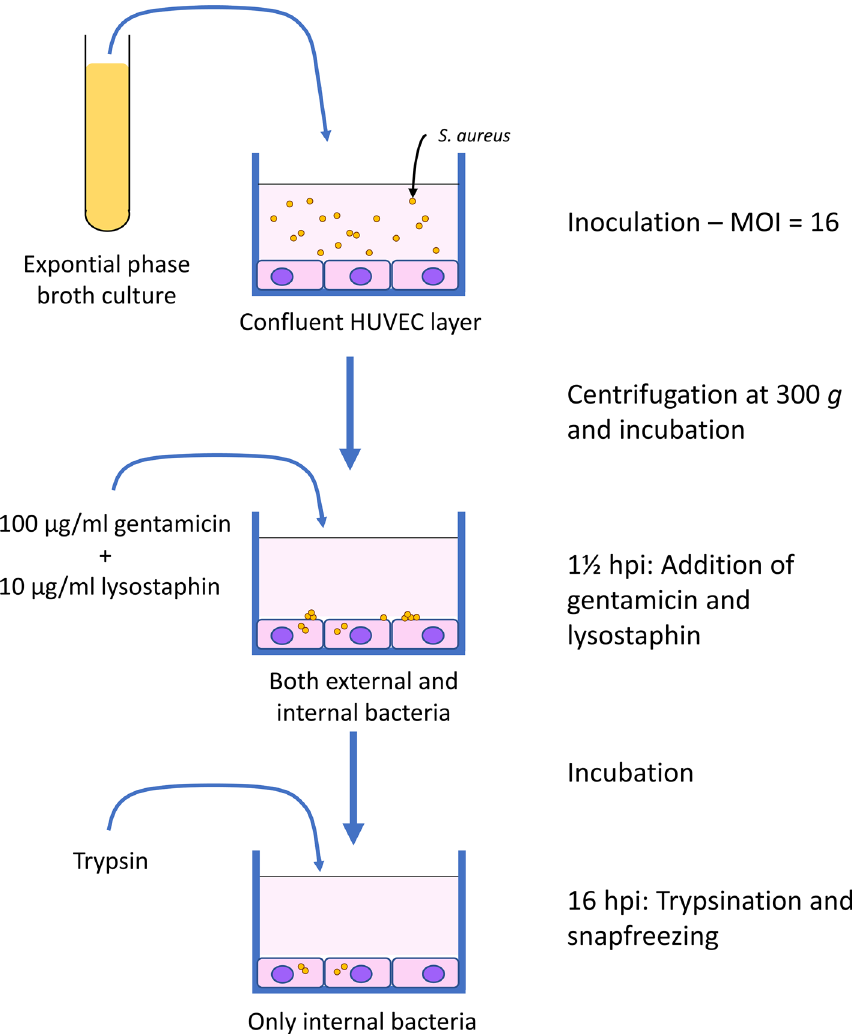
Figure 1. Flow chart of the infection assay. An exponential phase broth culture is prepared and used to inoculate microtiter plates containing confluent HUVEC layers using a multiplicity of infection of ∼ 16. After sedimentation of the bacteria by centrifugation at 300 g , the plates are incubated at 37 °C for 1½h. Then, 100 μg/ ml gentamicin and 10 μg/ml lysostaphin is added to kill and lyse all extracellular bacteria. For sample collection at 1 hpi and 16 hpi, the plates are washed and trypsinized followed by snap freezing and storage at − 80 °C until RNA